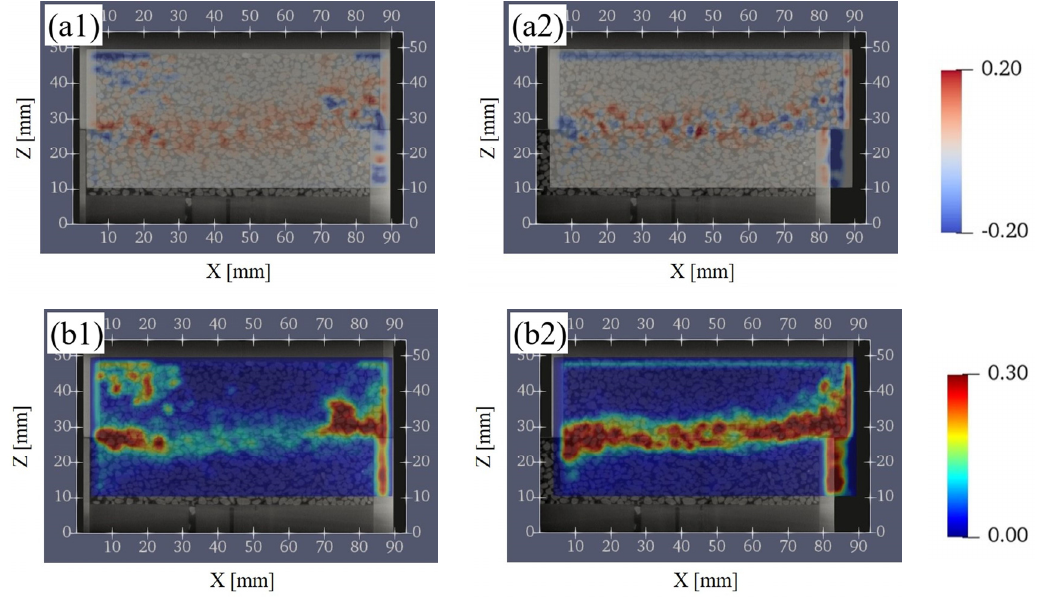
Figure 13. Digital image correlation (DIC) analysis results on the vertical plane (XZ plane). ( a1 , a2 ) are the volumetric strain, while ( b1 , b2 ) are the shear strain. The left columns show the analysis results based on the CT images of S1 (D h = 0.3 mm) and S2 (D h = 3 mm), and the right columns show the analysis results based on the CT images of S3 (D h = 5 mm) and S4 (D h = 8 mm). D h , horizontal displacement.